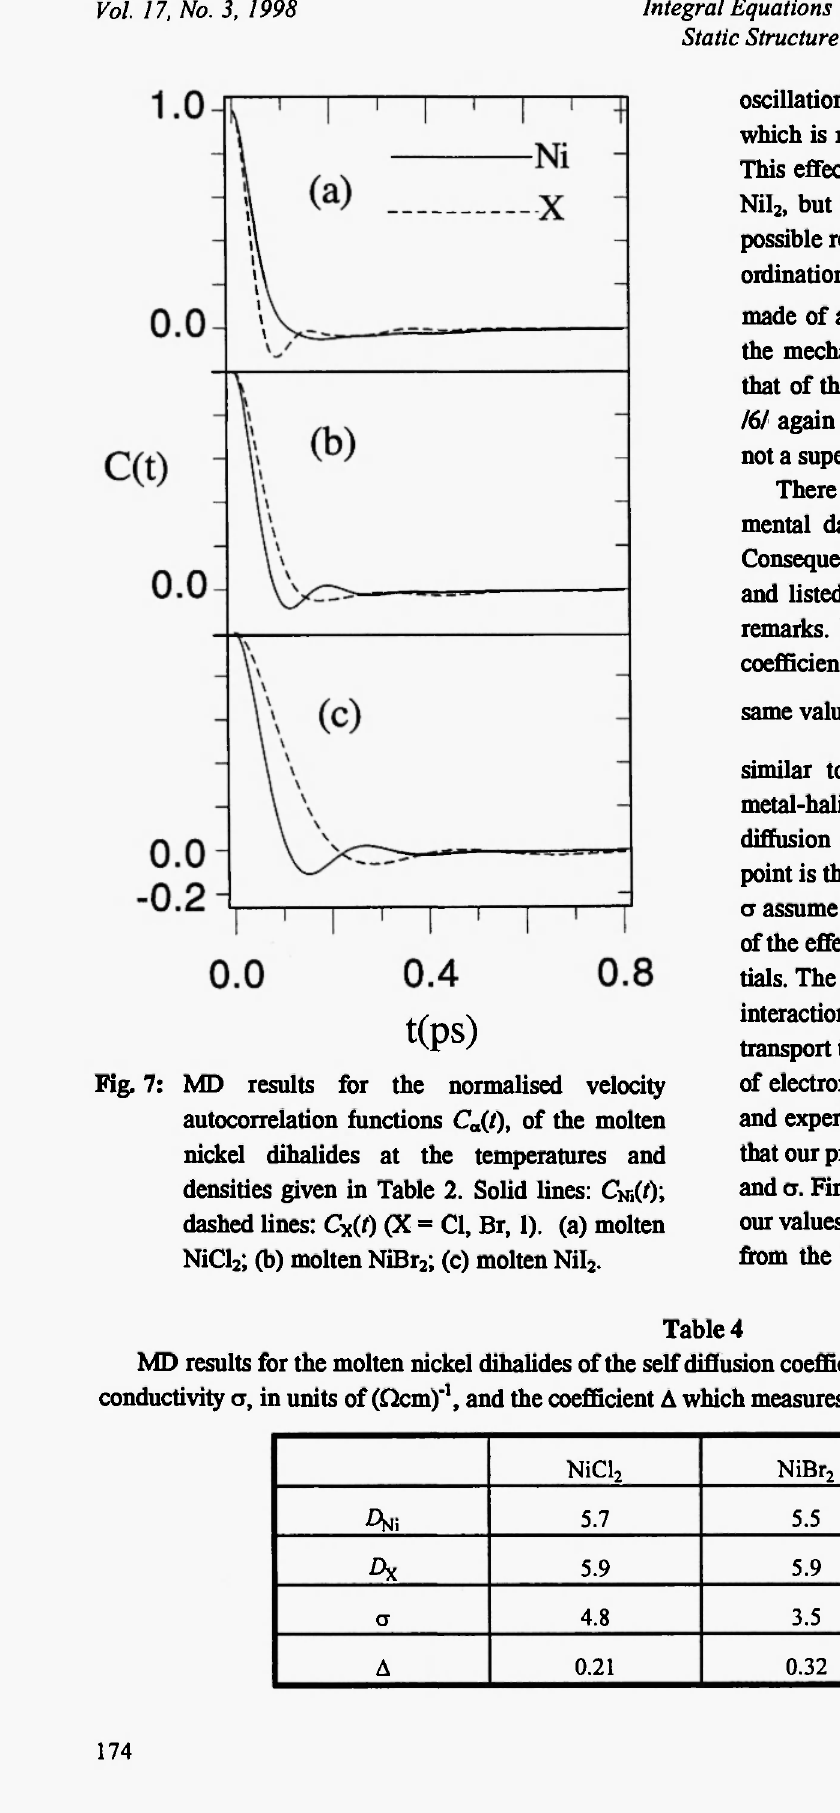
MD results for the molten nickel dihalides of the self diffusion coefficients Da, in units of 10" 5 cmV, the ionic conductivity σ, in units of (Qcm)" 1 , and the coefficient Δ which measures departures from the Nernst-Einstein